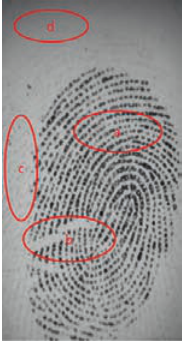
Figure 1. Fingerprint regions: (a) high quality ridge, (b) recoverable ridge, (c) traces from former acquisition, (d)